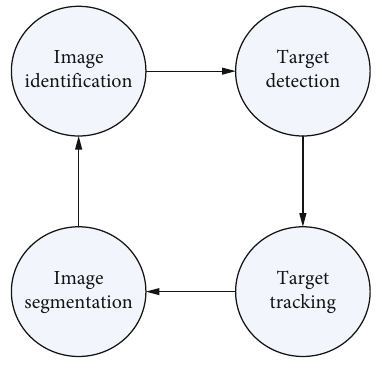
Figure 1: The main tasks of computer